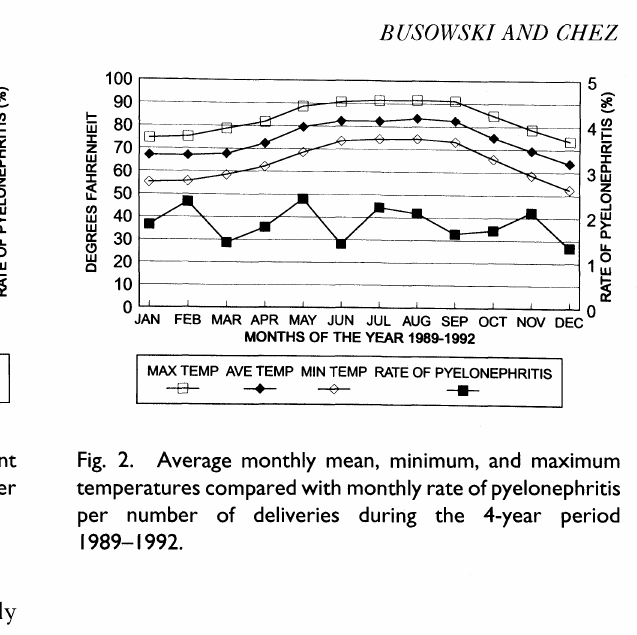
Fig. 2. Average monthly mean, minimum, and maximum temperatures compared with monthly rate of pyelonephritis per number of deliveries during the 4-year period